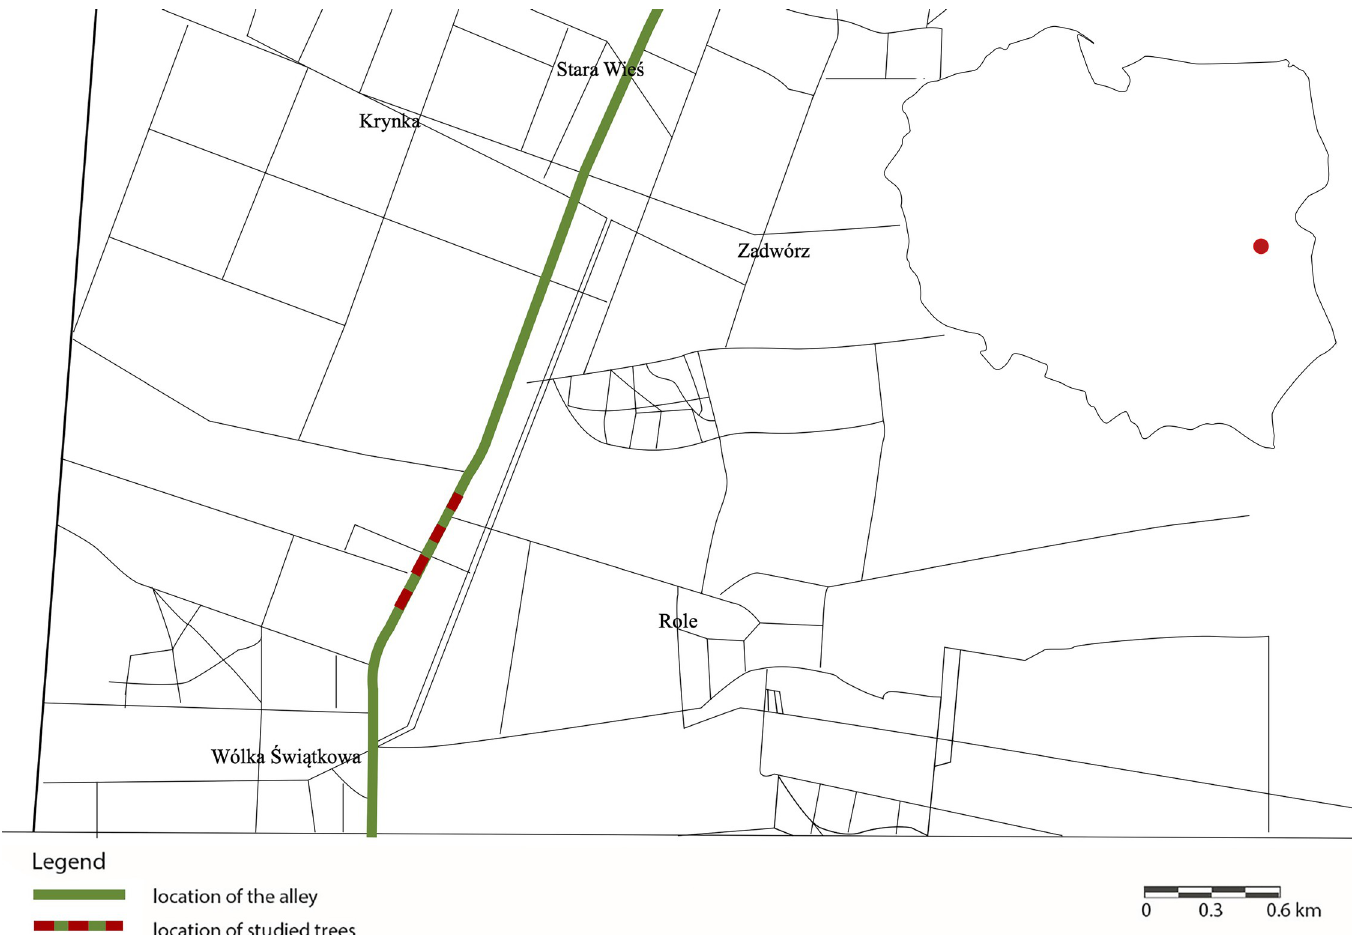
Fig 1. Location of the studied alley. With a read colour location of studied trees has been marked (source: Own elaboration).